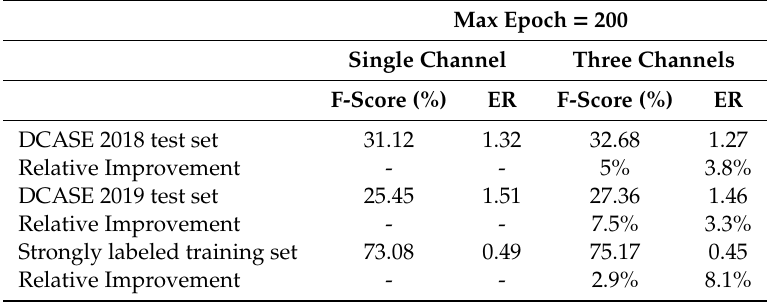
Table 6. SED results of the mean-teacher model using derivative features (max epoch =